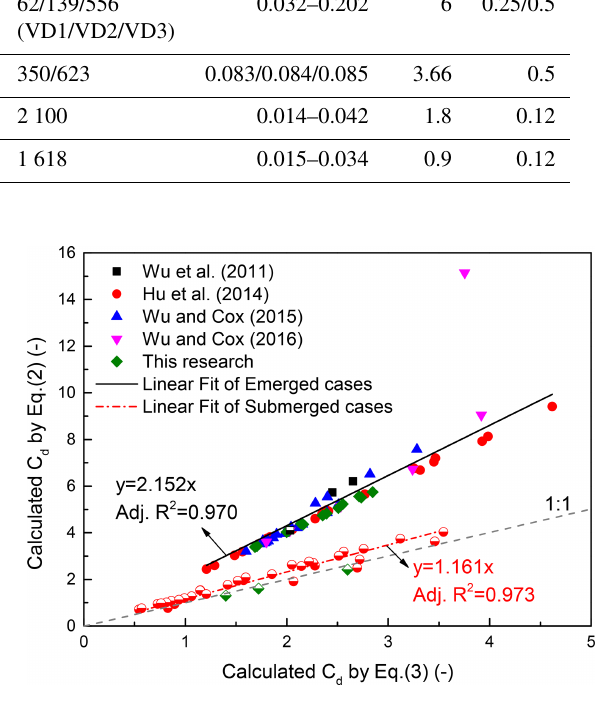
Figure 4. Comparison of the calculated values of C D by Eqs. (3) and (2). Different symbols indicate cases from different research studies, and partially and fully solid symbols denote submerged and emerged cases, respectively. The solid and dashed-dotted lines indi- cate linear fits of emerged and submerged